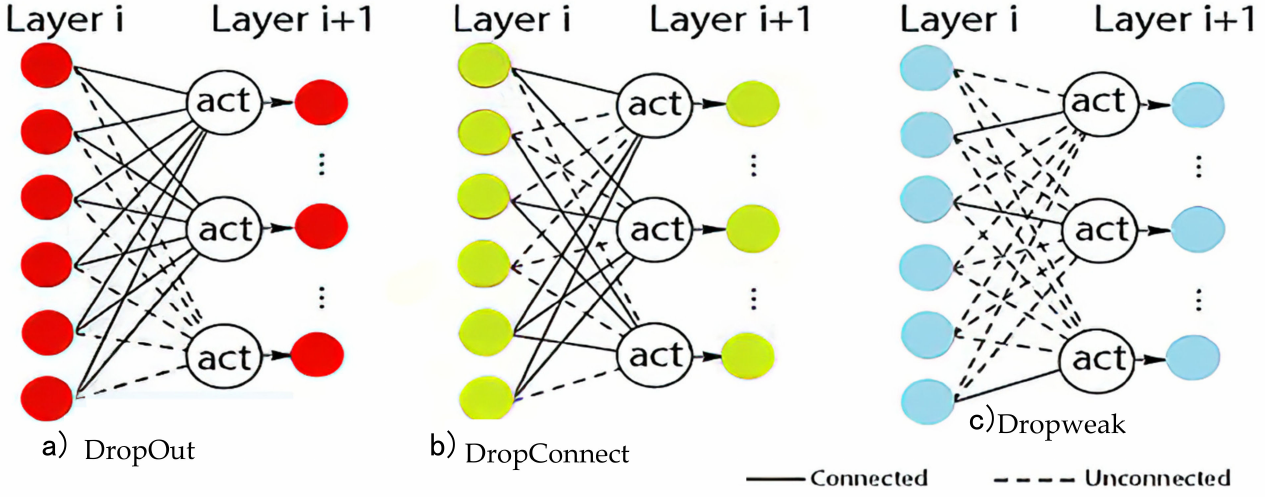
Figure 2. Comparison of ( a ) DropOut; ( b ) DropConnect and ( c ) MC Dropweak node